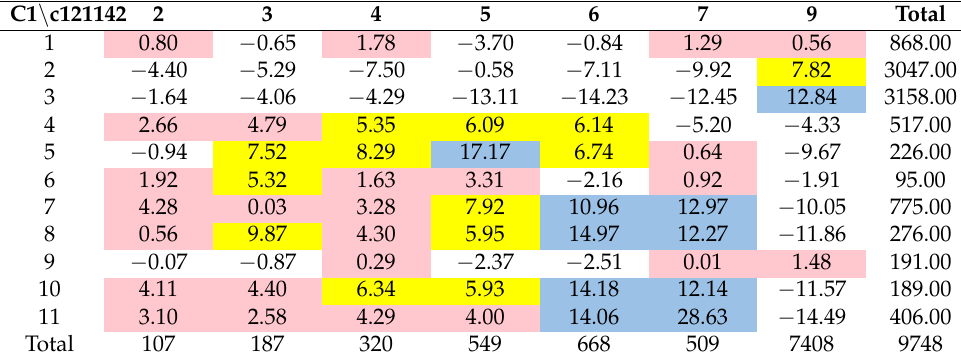
Table A4. Theoretical frequencies IMA 2018 (C1 \